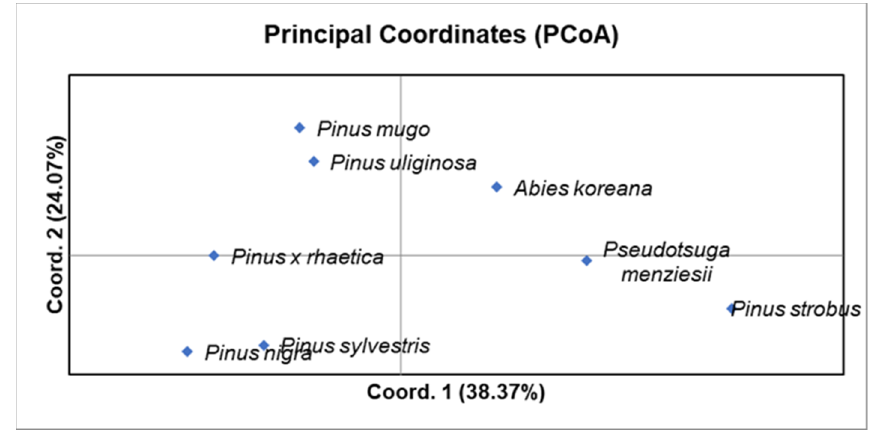
Figure 3. Principle coordinates analysis (PCoA) using Nei’s genetic distance (GD) for the eight taxa from the Pinaceae family.